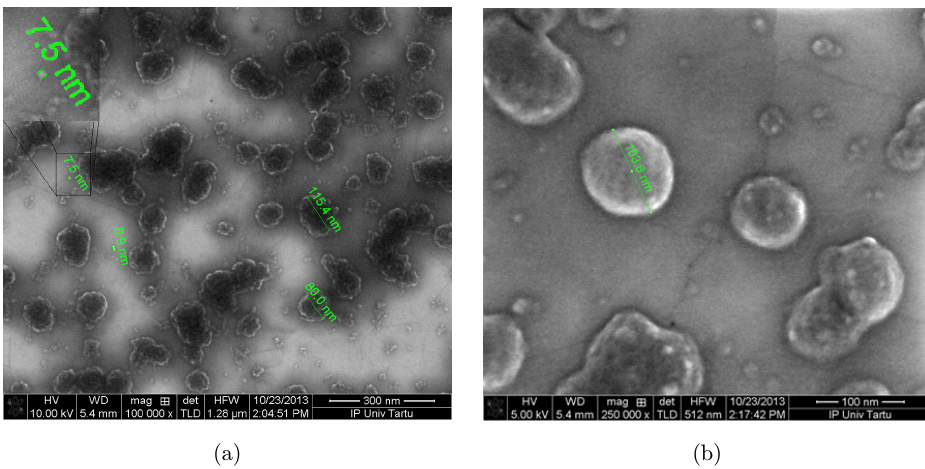
Fig. 1. SEM images of the VFS particles on a thin gold substrate with magni¯cation 100 000 (cid:4) (a) and 250 000 (cid:4) (b). Inset in Fig. 1 (a) demonstrates a magni¯ed separate NP of the diameter